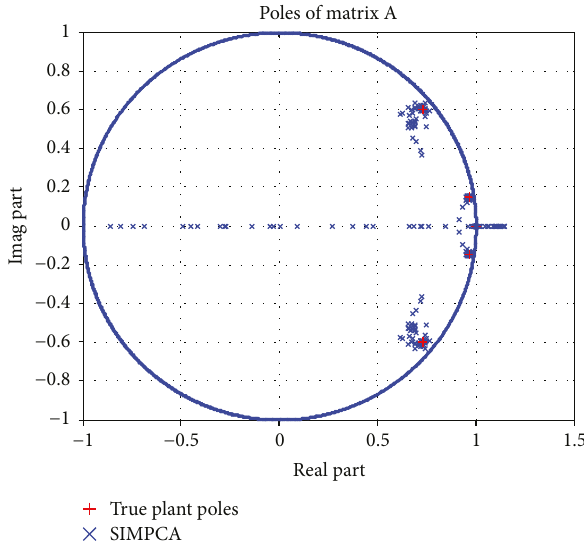
Figure 8: SIMPCA simulation and comparison of root loci.